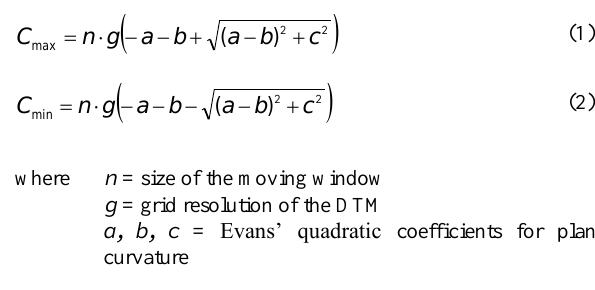
In Figure 6, an example of curvature map considered in this work is shown. In this case, the raster of C min has been evaluated using a 7x7 moving window.